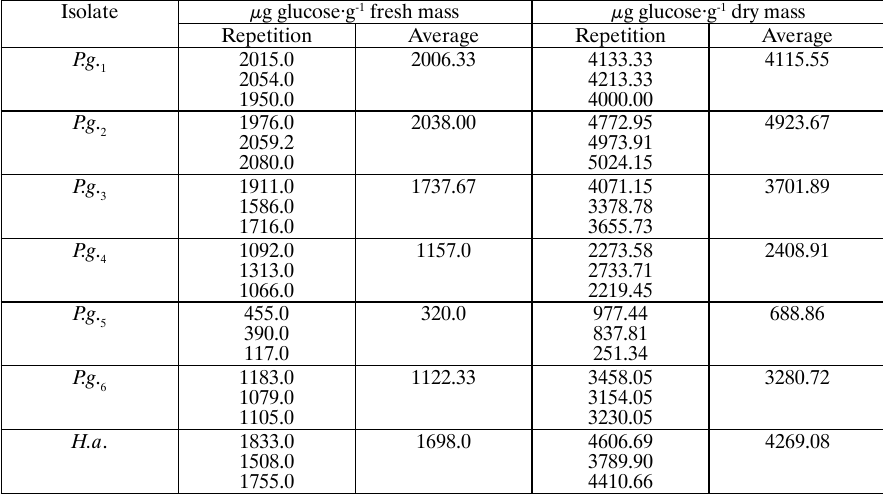
Cellulase activity of P. gigantea and H. annosum isolates